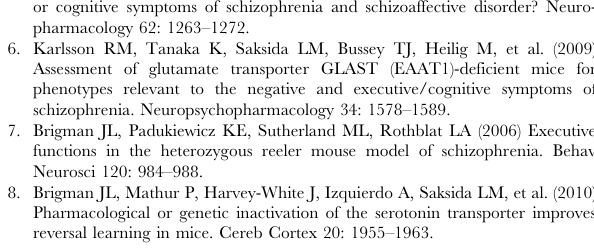
Figure S1 Inbred strain differences in stimulus-reac- tion time and reward-retrieval latency. Average stimulus- reaction time ( A ) and reward-retrieval latency ( B ) during discrimination. Average stimulus-reaction time ( C ) and reward- retrieval latency ( D ) during reversal. n= 9–27 per strain. Data are Means 6 SEM. (DOCX) Figure S2 Stress effects on stimulus-reaction time and reward-retrieval latency in DBA/2J and C57BL/6J mice. Average stimulus-reaction time ( A ) and reward-retrieval latency ( B ) during discrimination. Average stimulus-reaction time ( C ) and reward-retrieval latency ( D ) during early and late reversal learning. n= 10–13 per stress group, per strain. { P , .05 non- stressed DBA/2J vs. non-stressed C57BL/6J, { P , .05 stressed DBA/2J vs. stressed C57BL/6J. Data are Means 6 SEM. (DOCX) Figure S3 Stress effects on re-reversal learning in DBA/ 2J and C57BL/6J mice. Sessions ( A ), errors ( B ) and correction errors ( C ) to re-reversal criterion. Average stimulus reaction time ( D ) and reward latency ( E ) across re-reversal. Sessions ( F ), errors ( G ) and correction errors ( H ), and average stimulus reaction time ( I ) and reward latency ( J ) during early and late re-reversal. n= 10–13 per stress group, per strain. * P , .05 stressed vs. non-stressed control C57BL/6J, { P , .05 non-stressed DBA/2J vs. non-stressed C57BL/6J, { P , .05 stressed DBA/2J vs. stressed C57BL/6J. Data are Means 6 SEM. Figure S4 BXD-RI strain differences in stimulus-reac- tion time and reward-retrieval latency. Average stimulus- reaction time ( A ) and reward-retrieval latency ( B ) during discrimination. Average stimulus-reaction time ( C ) and reward- retrieval latency ( D ) during reversal. n= 1–14 per strain. Data are Means 6 SEM. Figure S5 BXD-RI strain differences in extinction learning. Errors ( A ), correction errors ( B ) to extinction criterion and average stimulus-reaction times ( C ). n= 1–14 per strain. Data are Means 6